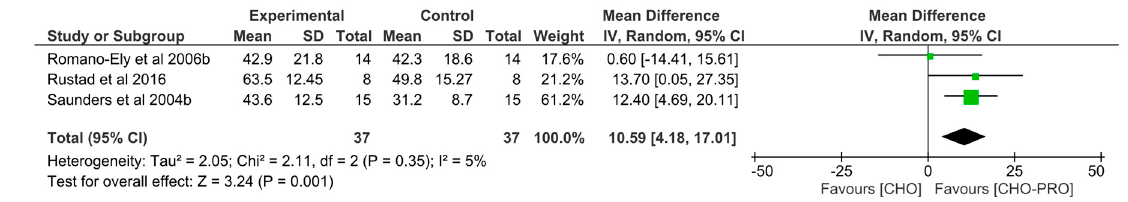
Figure 7. Effect of CHO-PRO intake during long-term recovery on TTE performance compared to CHO. CI: confidence interval; MD: mean difference.